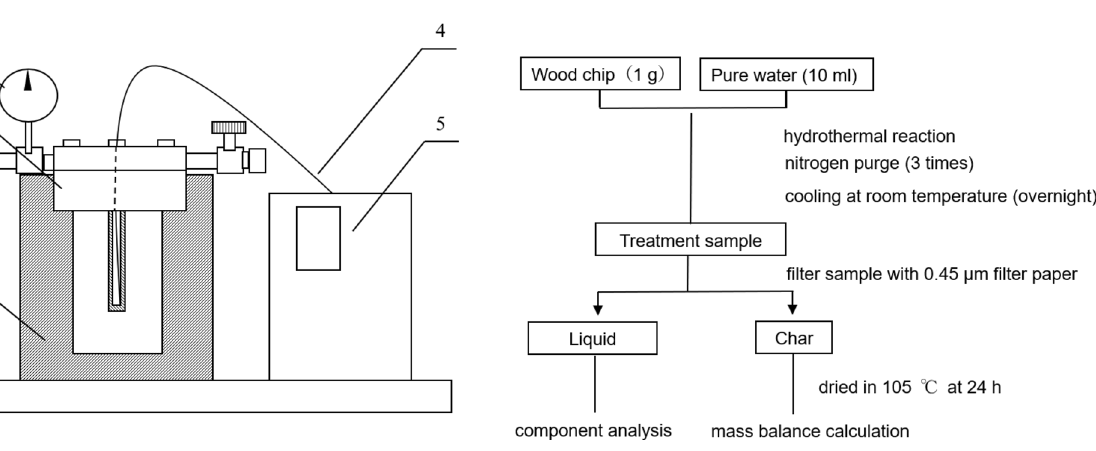
Fig. 1 Schematic diagram of a hydrothermal reactor. 1 = pressure gauge, 2 = reactor body, 3 = heater, 4 = thermocouple, 5 = control unit